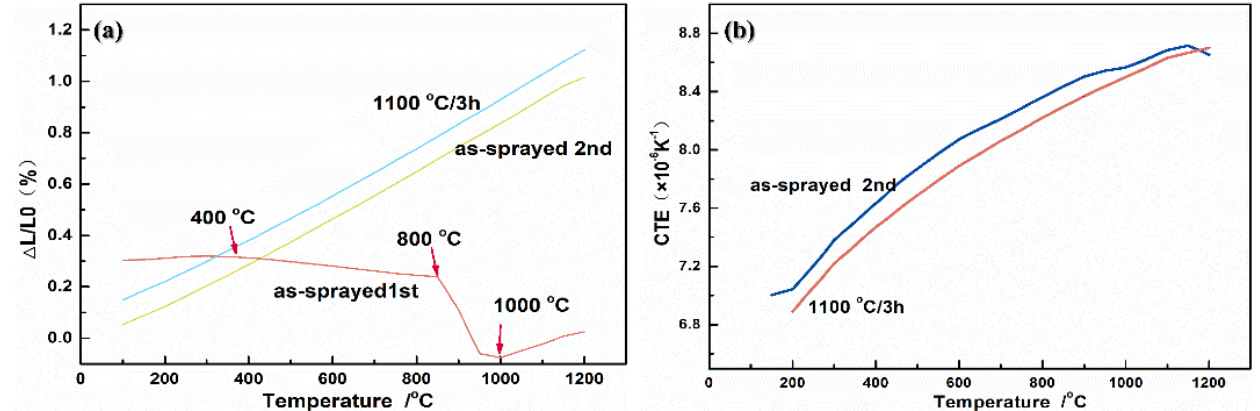
Figure 11. Δ L/L 0 curves ( a ) and CTE curves ( b ) of as-sprayed and 1100 °C/3 h aged CZSO